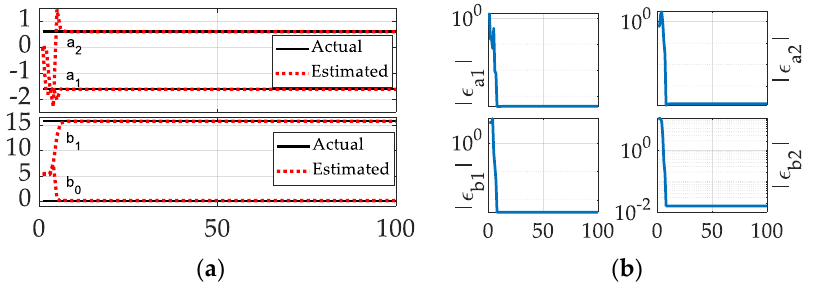
Figure 6. Indirect self-tuner without process zero cancellation (non-minimum phase plant) with timesteps on the abscissa. ( a ) Parameter estimation. ( b ) Extended least squares’ estimation of the residuals or innovations.